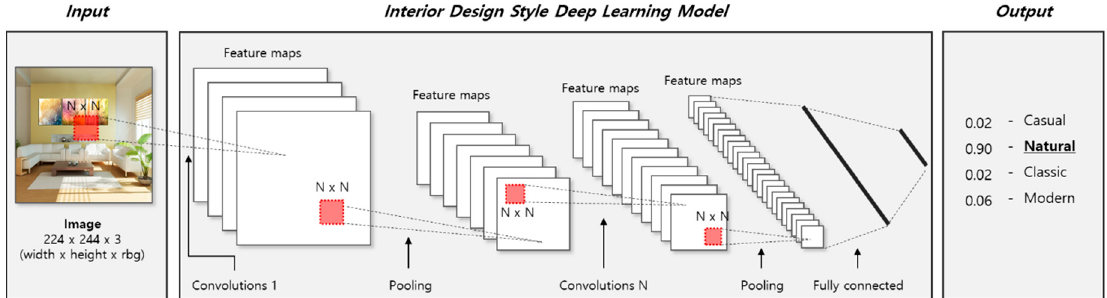
Figure 5. Conceptual structure of the interior design style recognition model based on a pre-trained model.